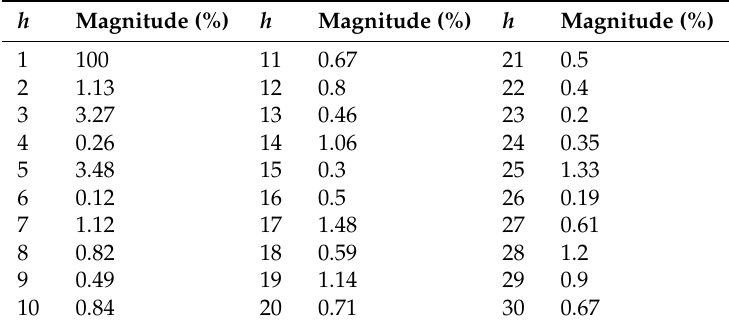
Table A3. The harmonic currents of a typical DG unit (PV-based)